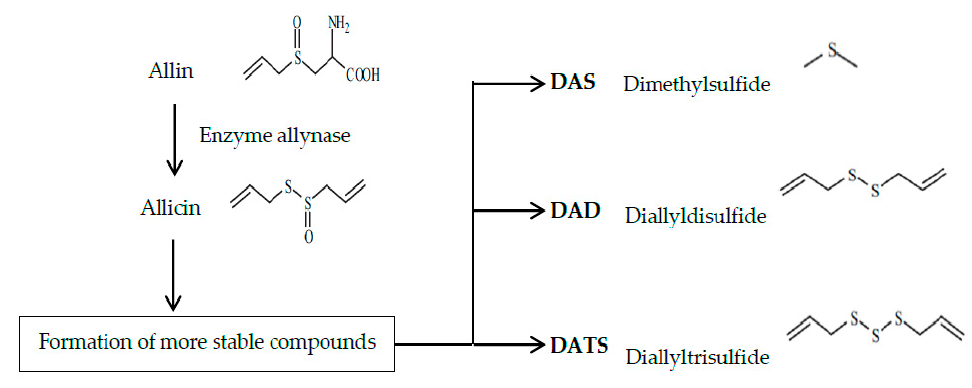
Figure 1. Allin transformation to more stable compounds.